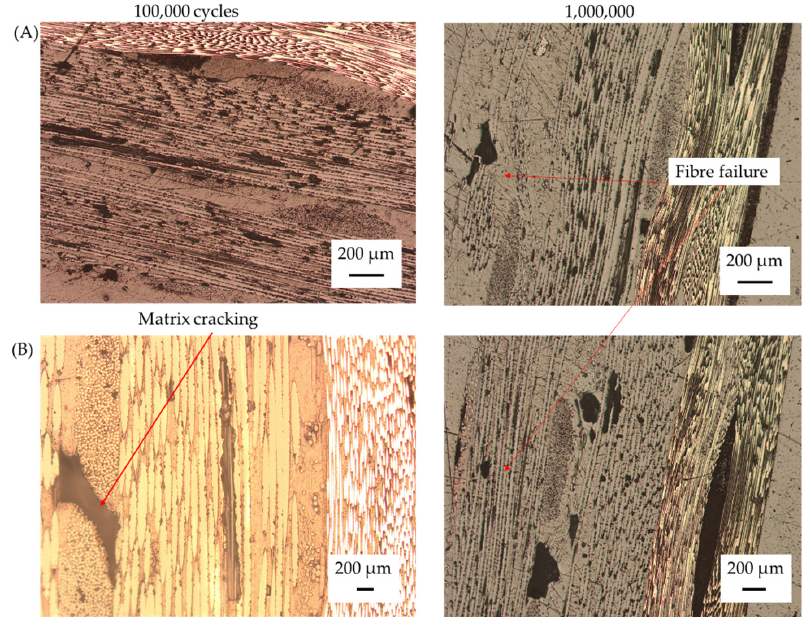
Figure 16. Optical images of hybrid carbon and glass fibre after three-point bending at 50% maximum flexural strength for: ( A ) HF after 100,000 and 1,000,000 cycles; ( B ) HFT 100,000 and 1,000,000 cycles.